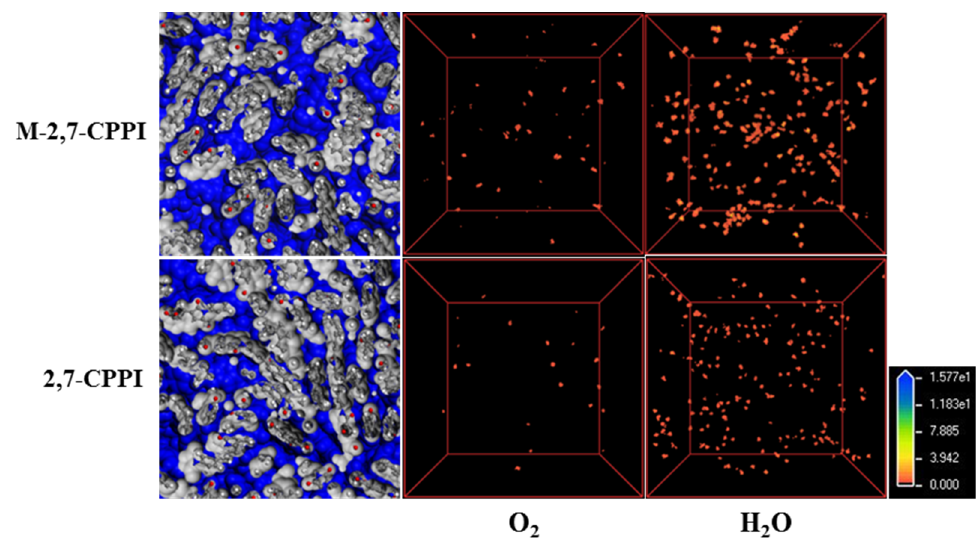
Figure 12. The adsorption isotherms of O 2 and H 2 O in M-2,7-CPPI and 2,7-CPPI.